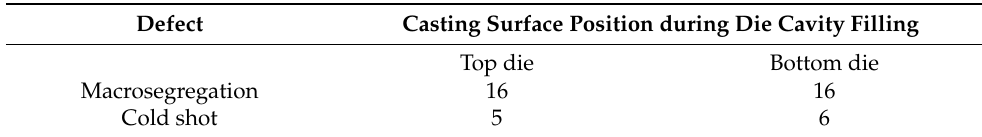
Table 2. Number of defects that initiated fatigue crack and distribution as a function of the casting surface position during die cavity